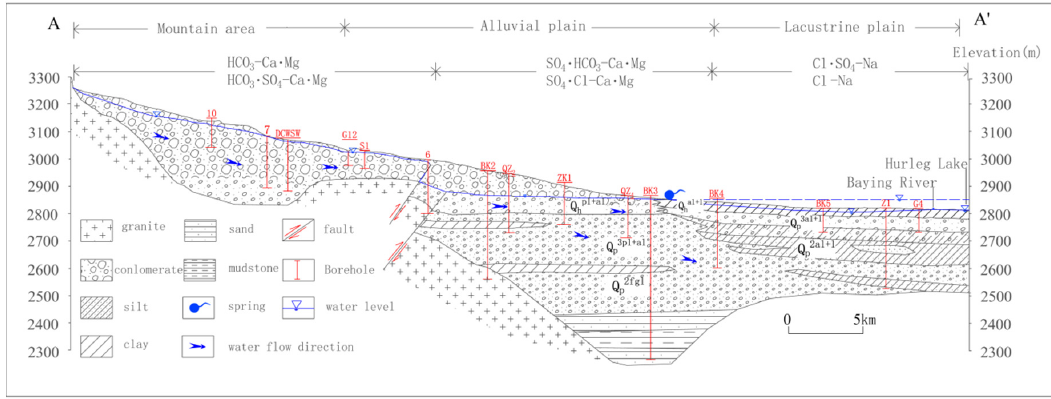
Figure 2. Hydrogeological profile of A–A’.